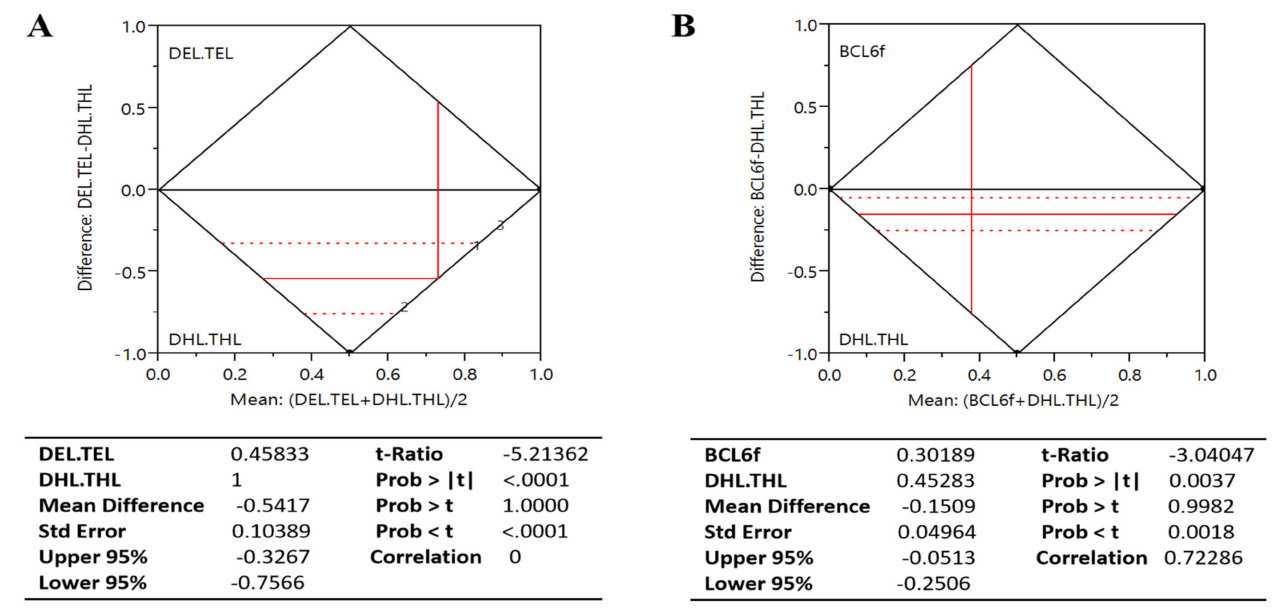
Figure 3. Patients with DHL or THL mostly harbor BCL6 rearrangement, are mostly BCL6 expressors, but are not necessarily double or triple expressors. ( A ) Chart showing the difference between the means of our high-grade B-cell lymphoma (HGBL) with MYC and BCL2 and/or BCL6 rearrangements (DHL/THL) and those with MYC and BCL2 and/or BCL6 protein expression (DEL/TEL). ( B ) Chart showing the difference between the means of our high-grade B-cell lymphoma (HGBL) with MYC and BCL2 and/or BCL6 rearrangements (DHL/THL) and those with BCL6-rearrangement (BCL6f). DHL, double hit lymphoma; THL, triple hit lymphoma; DEL, double expressor lymphoma; TEL, triple expressor lymphoma; BCL6f,